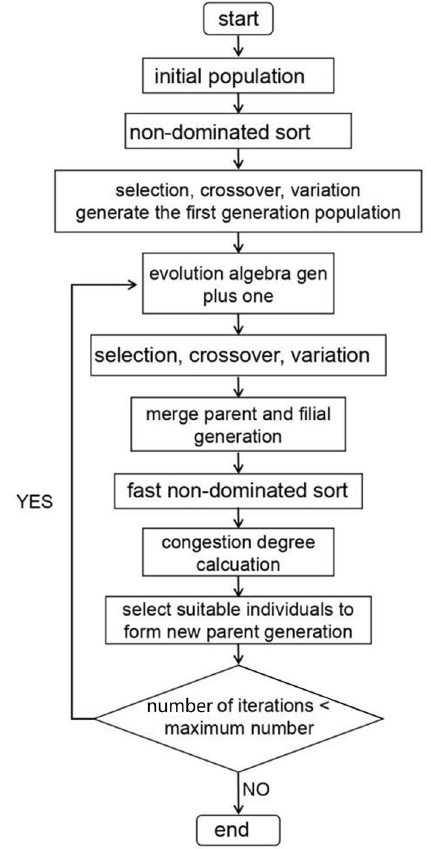
Fig. 1 Flowchart of solving NSGA-II